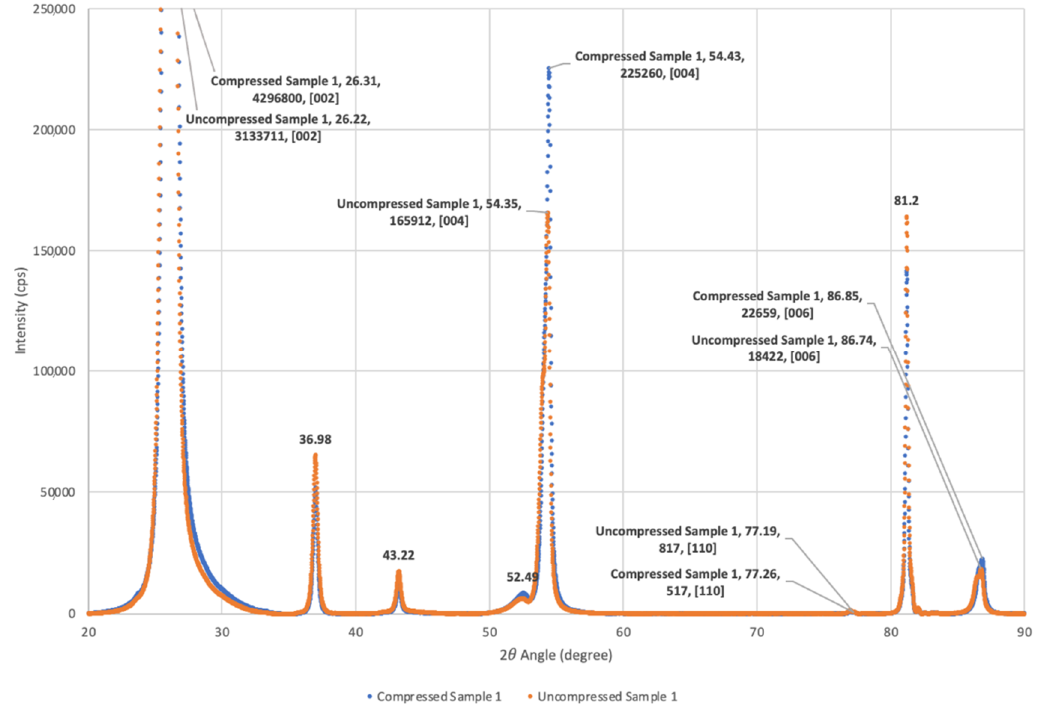
Figure 1. Compressed and Uncompressed Grafoil XRD . Both compressed and uncompressed XRD show high orientation of [002] graphite basal planes parallel to surface. For the true powder pattern dif- fraction pattern arising from ground Grafoil, the [110] (77.19° 2θ) and [112] (81.2° 2θ) diffraction lines are nearly equal in intensity. In contrast to the powder pattern, for both the compressed and uncompressed materials employed in this study, the [110] peak is nearly invisible, but the [112] peak is quite strong [21]. (Note: Only ~6% of the [002] reflection is shown in order to allow the relative intensity of the other peaks to be clearly shown). EDLC Electrode Structure: To test the impact of orientation, electrodes were made of Grafoil that was folded to form an accordion structure, in which each fold was 1 cm across and 3 cm long (Figure 2).